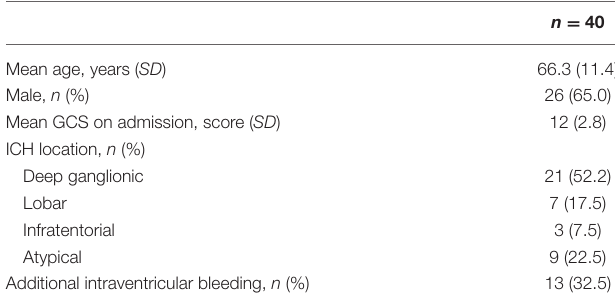
TABLE 1 | Patients’